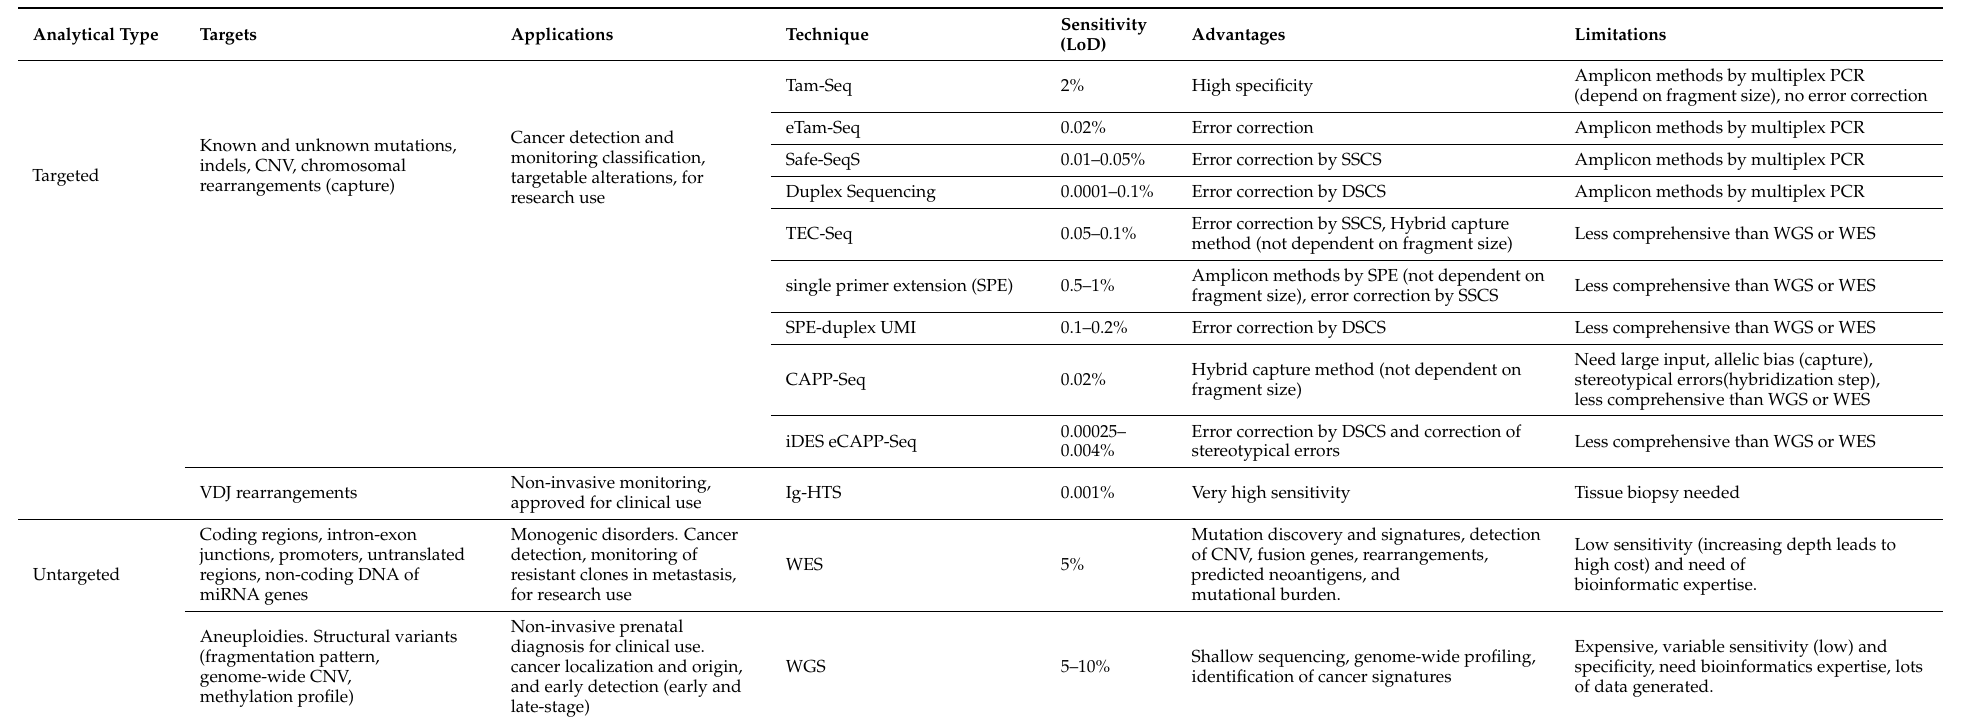
Table A1. Comparison of NGS-based methods for ctDNA detection. Adapted from Bohers et al.